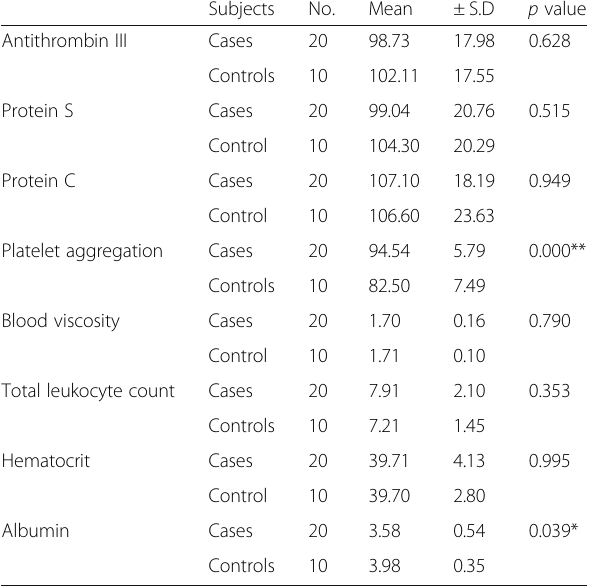
Regression analysis